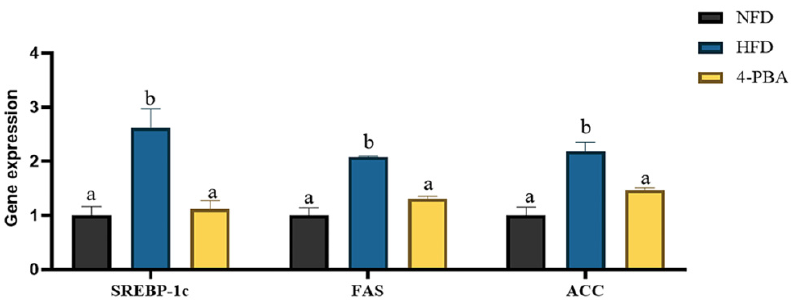
Figure 7. Experiment II. The liver’s expression of genes associated with fat metabolism. Gene expression of srebp-1c , fas , and acc . All values are exhibited as mean ± SE. Different letters indicate a significant difference among groups ( p < 0.05, Tukey’s test, n = 3).